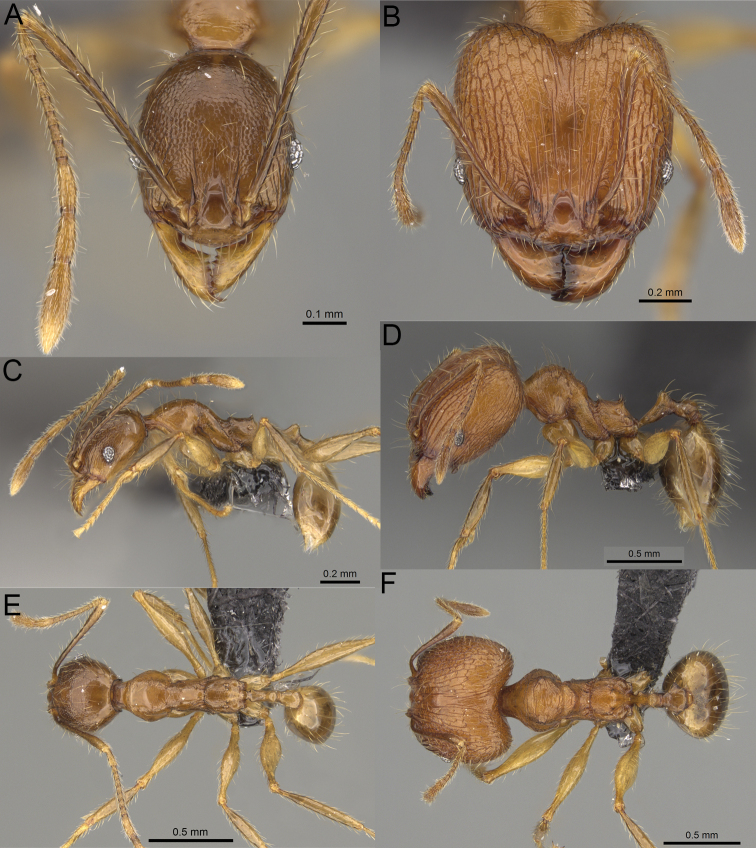
Pheidole
dasos sp. nov., full-face view (A), profile (C), and dorsal view (E) of paratype minor worker (CASENT0923284) and full-face view (B), profile (D), and dorsal view (F) of holotype major worker (CASENT0212441).